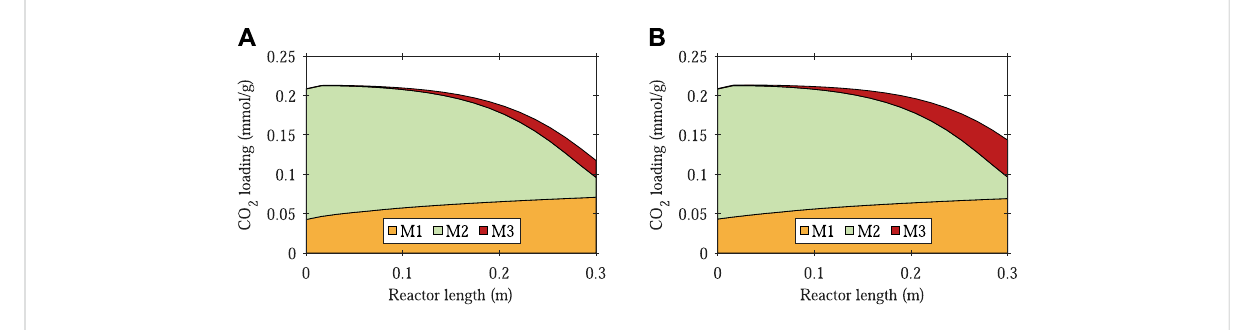
FIGURE 10 MATLABSimulinkresultsforthepilotplantbasecasesimulationinserialcon fi guration.CO 2 loadingattheendofeachreactiveadsorptionmode for cycle5inchamber1 overthereactor length. The switch fromM2to M3is triggered as soonas y {CO The switch from M3 to M4 occurs when the CO 2 volume fraction to the subsequent chamber is (A) y {CO